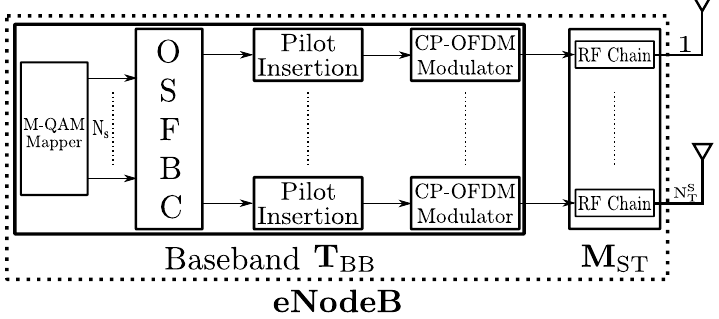
Figure 1. Baseband eNodeB architecture.